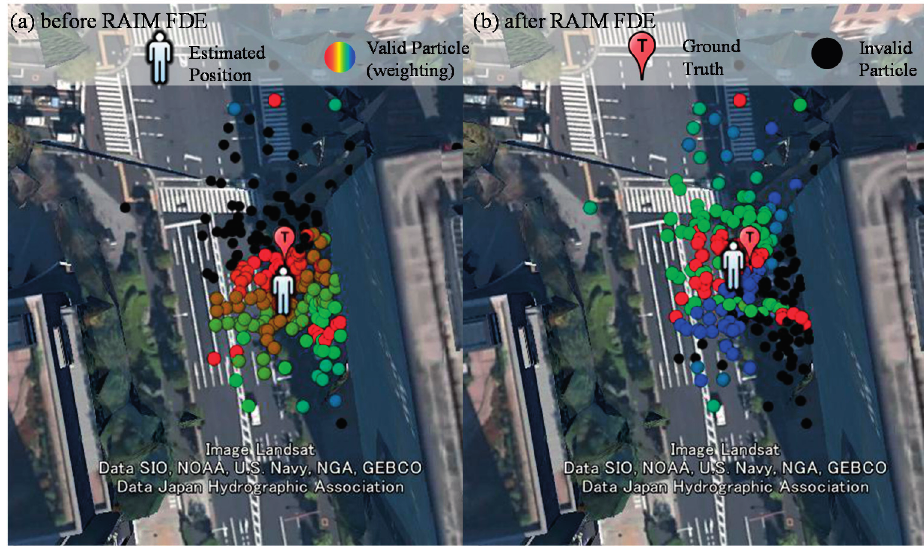
Figure 10. Weighting of all the particles of point 264,308 before ( a ) and after RAIM ( b ).